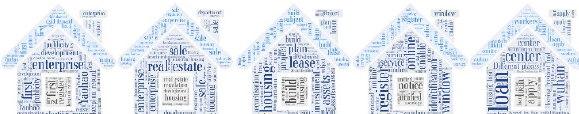
Figure 6. Cloud map visualization of policy keywords in June 2018, the pictures indicate Priority to Just needed family,